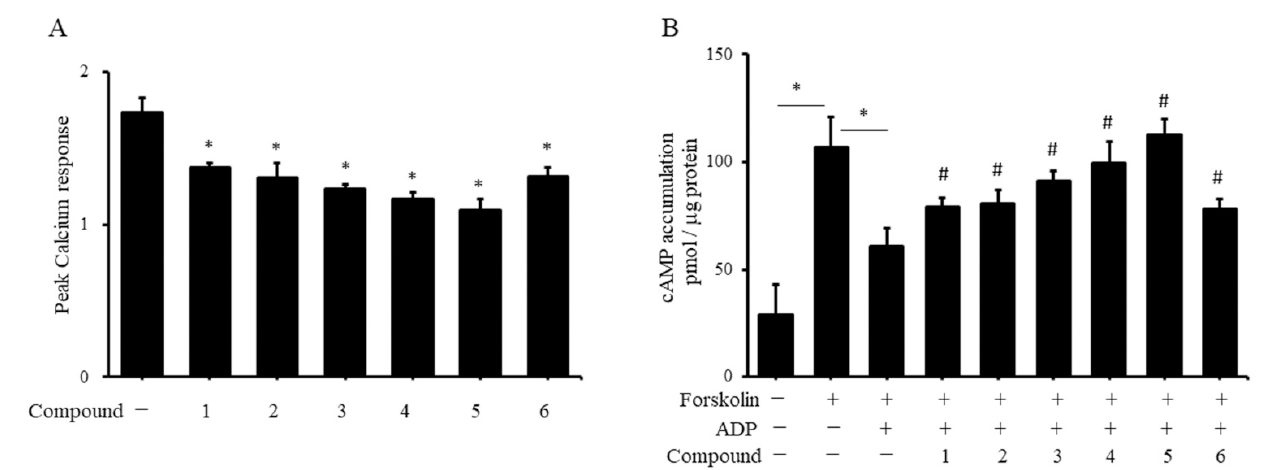
Figure 5. Effects of coumarin derivatives on calcium and cAMP production in human platelets. Human PRP was treated with 10 ppm of coumarin derivatives for 1 h, and Fura-2AM reagent was added. Purified plate isolates were treated with 10 μM ADP, and calcium concentration was monitored in an EIA reader. Data are presented as the fold change relative to control group not treated with ADP ( A ). * p < 0.05 compared with control group. Human PRP was treated with 10 ppm of coumarin derivatives for 1 h, and isolated platelets were treated with 10 μM forskolin and 10 μM ADP for 5 min. Platelet lysates were prepared, and cAMP levels were measured using an enzyme immunoassay ( n = 3). * p < 0.05 between two groups. # p < 0.05 for PRP treatment of indicated compound followed by forskolin and ADP stimulation compared with PRP stimulated with forskolin and ADP alone ( B ).